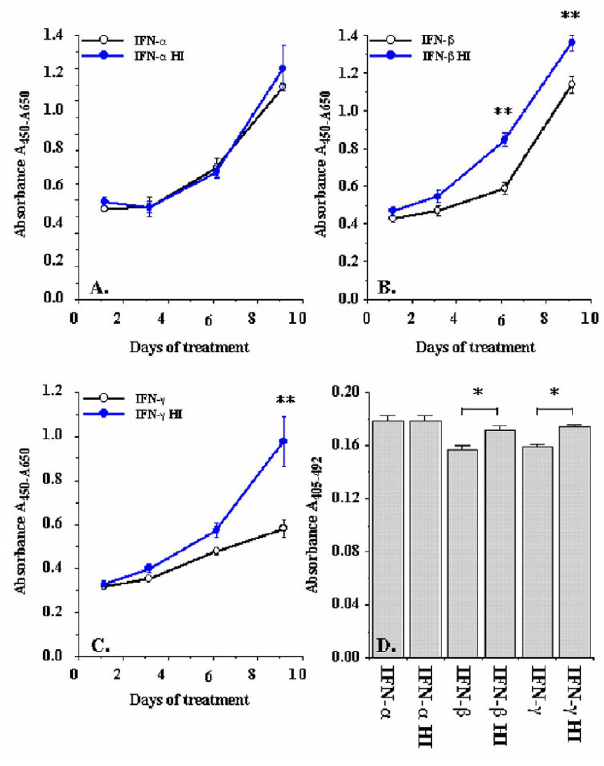
Figure 3 Interferons regulation of rat hepatic stellate cell proliferation. Sub-cultured hepatic stellate cells were incubated with 500 U/ml of interferons for the days indicated. Cell proliferation was performed by WST-1 cell proliferation and BrdU incor- poration assays. Panel A exhibits the effect of IFN- α on cell proliferation. Panel B indicates the effect of IFN- β on cell proliferation. Panel C displays the effect of IFN- γ on cell pro- liferation. Panel D exhibits the IFNs effect on BrdU incorpo- ration in rat HSCs. The data represent mean ± SEM. HI represents heat-inactivation. * indicates p < 0.05 and ** indi- cates p <